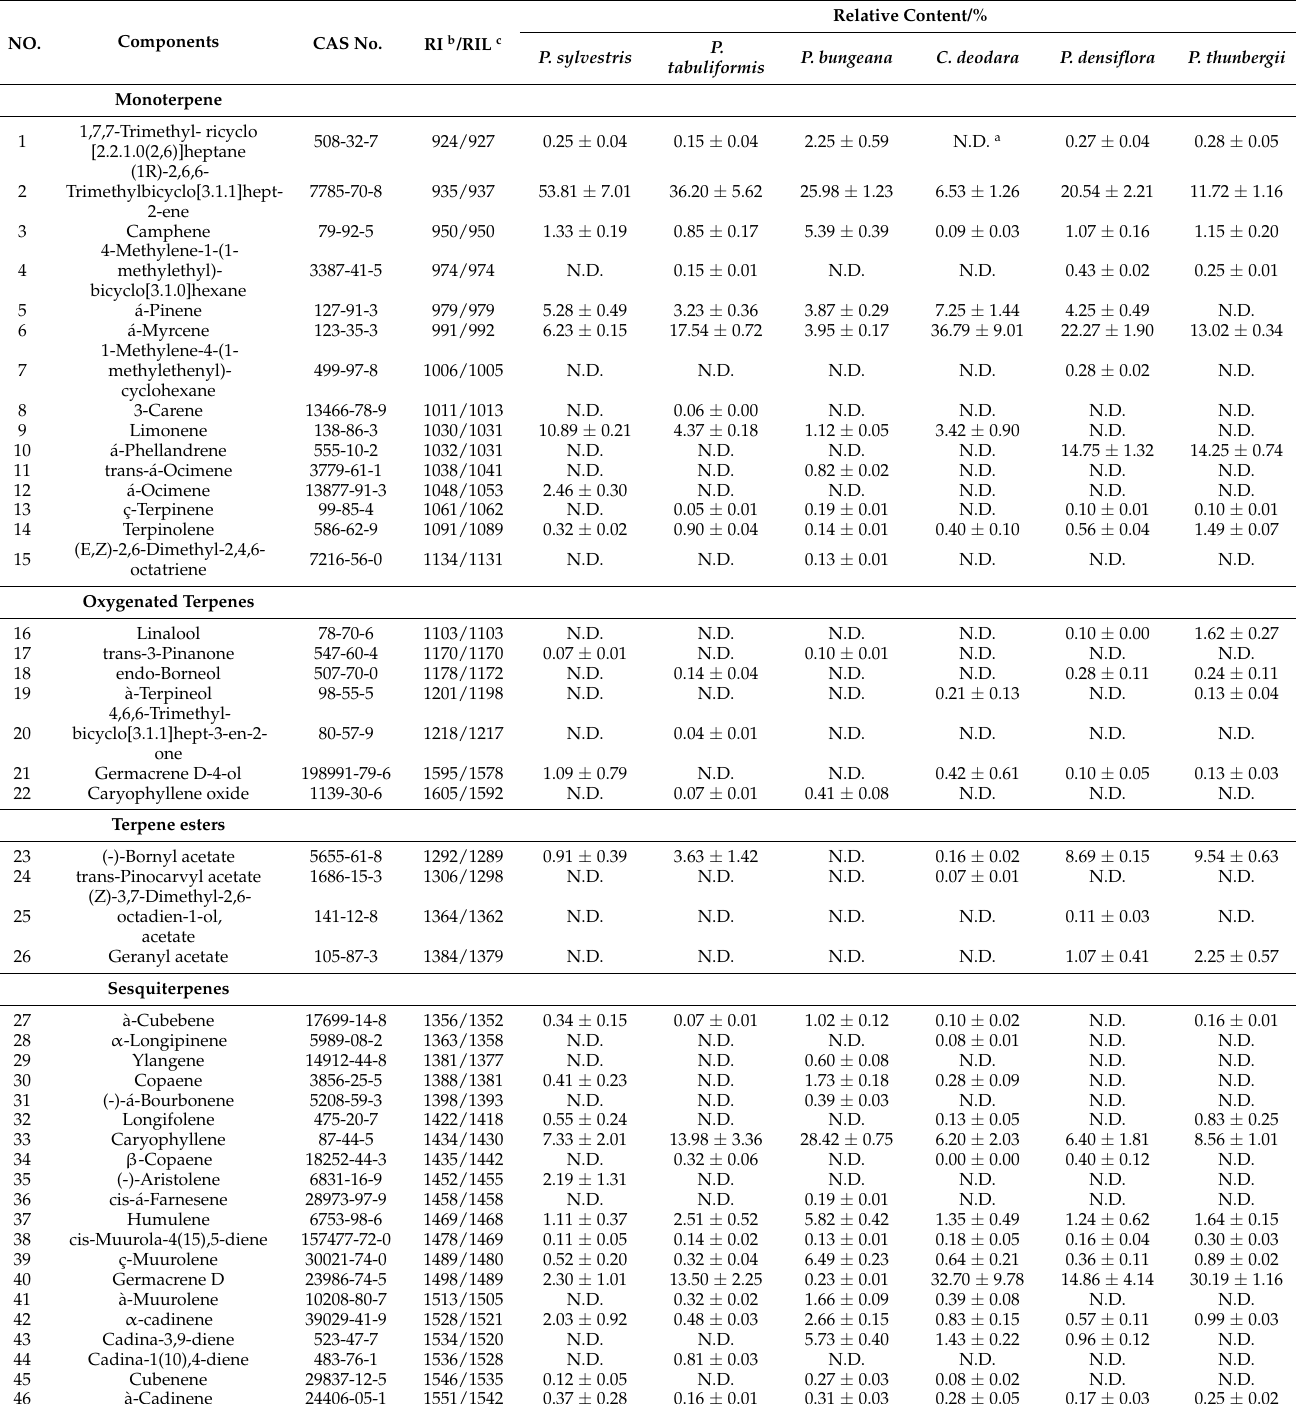
Table 1. Identification of volatile terpenes and terpenoids components and relative contents of compounds in pine leaves (Means ±